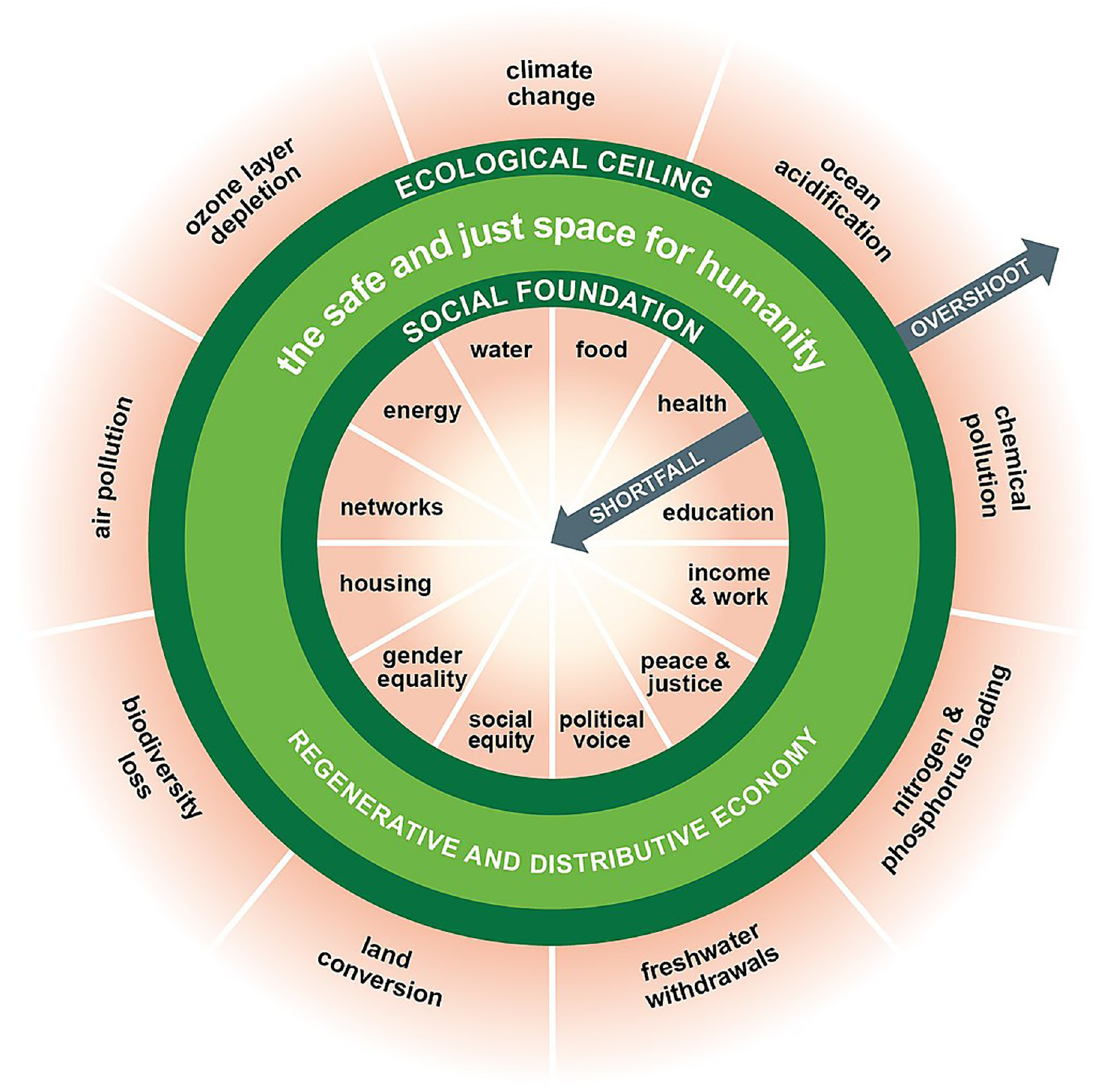
Fig 3. Doughnut economics: A framework for how the economy could develop within a safe environmental space and just social space